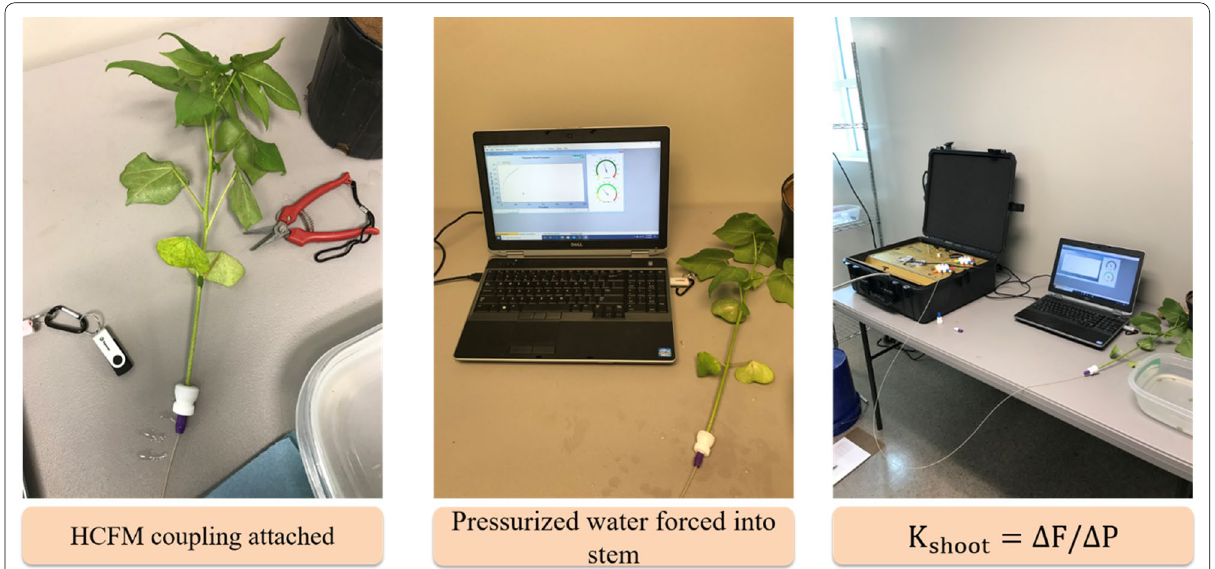
Fig. 1 Process of measuring shoot hydraulic conductance [K shoot conductance flow meter